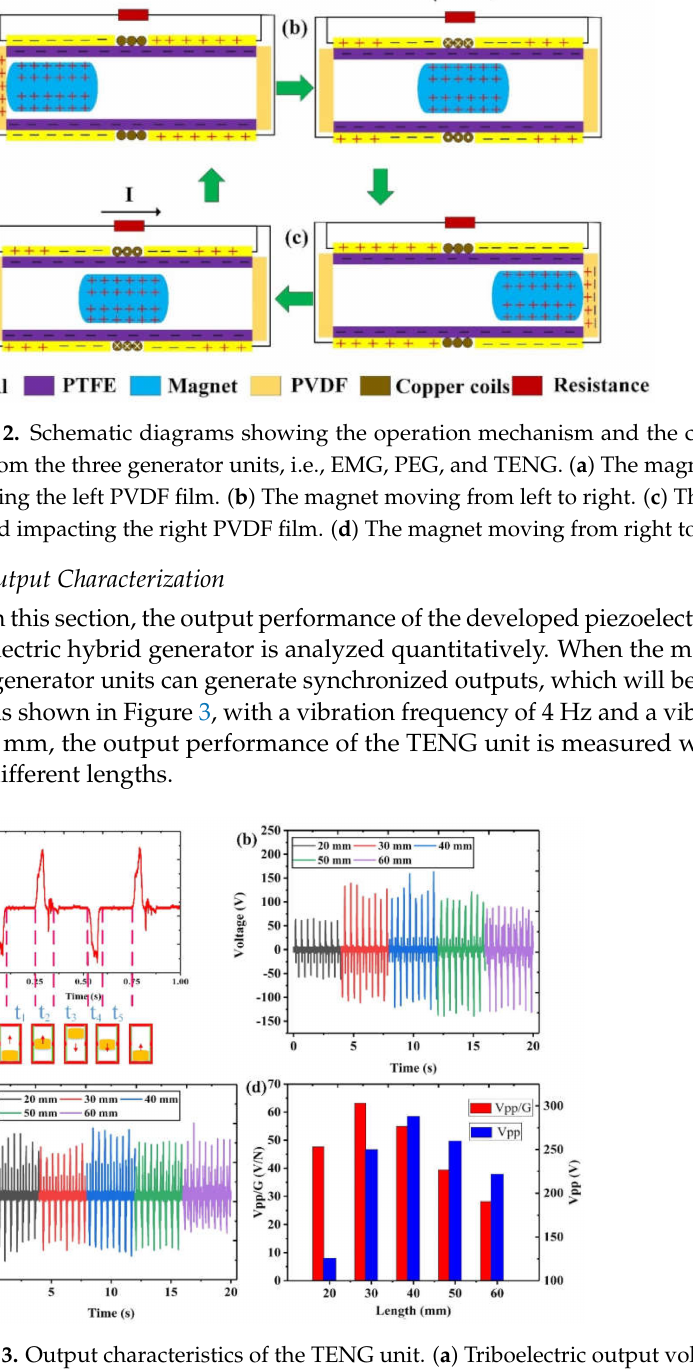
Figure 3. Output characteristics of the TENG unit. ( a ) Triboelectric output voltage corresponding to different stages within one cycle. ( b ) Output voltages and ( c ) output currents of the TENG unit under different magnet lengths. ( d ) Performance comparison of the output voltage and voltage per unit weight for different magnet